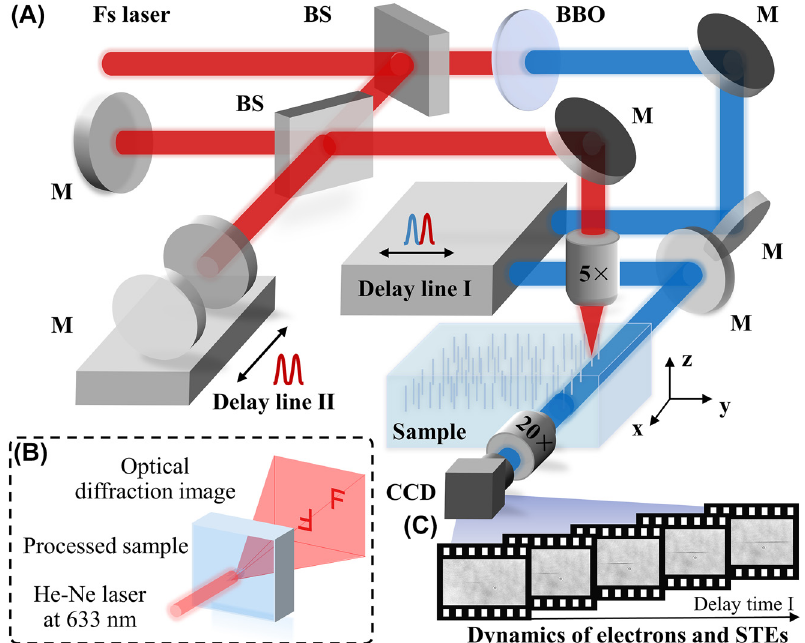
Figure 1: Schematic of experimental